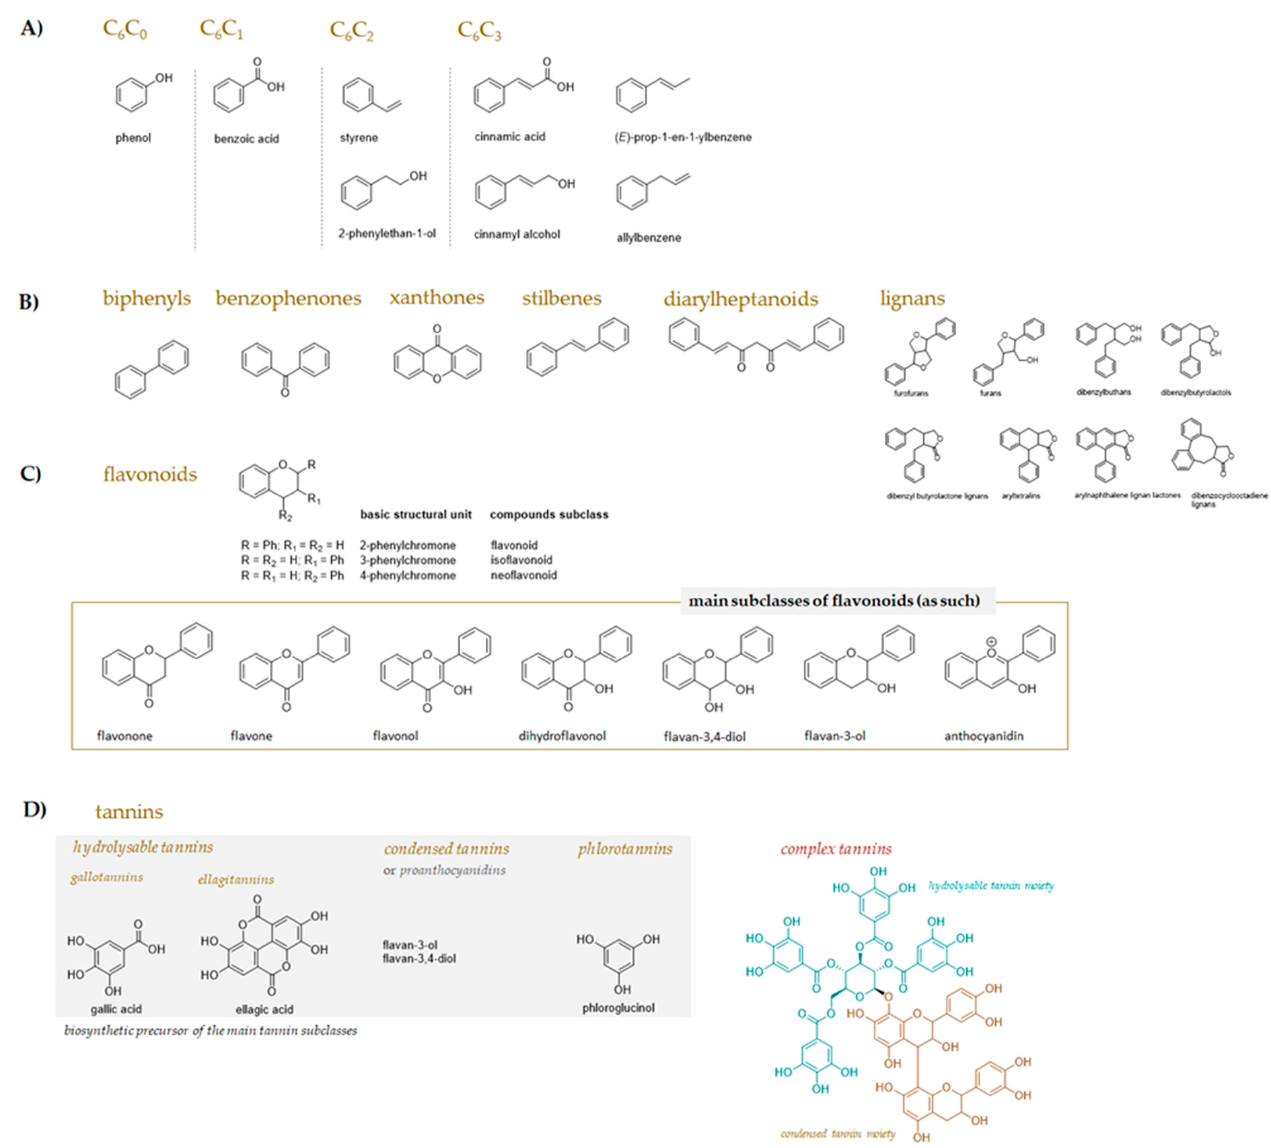
Figure 2. Main phenol and polyphenol skeletons. ( A ) Simple phenols (C 6 C 0 , C 6 C 2 compounds) and phenolic acids (C 6 C 1 , C 6 C 3 compounds); ( B ) non-flavonoidic polyphenols; ( C ) flavonoidic polyphenols and depiction of the skeleton of the main flavonoid subclasses; ( D ) tannins’ classification and depiction of the main precursor of each subclass.